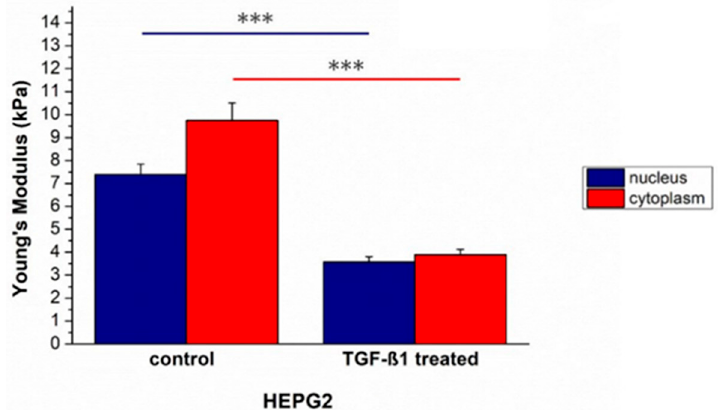
Figure 2. The Young’s modulus values with standard deviation, calculated from the nuclear region and the cytoskeletal area respectively, were reported for untreated HepG2 CTR and TGF- β 1 treated HepG2 TGF- β 1 cells. Results were statistically significant for p < 0.005 (indicated as ***).